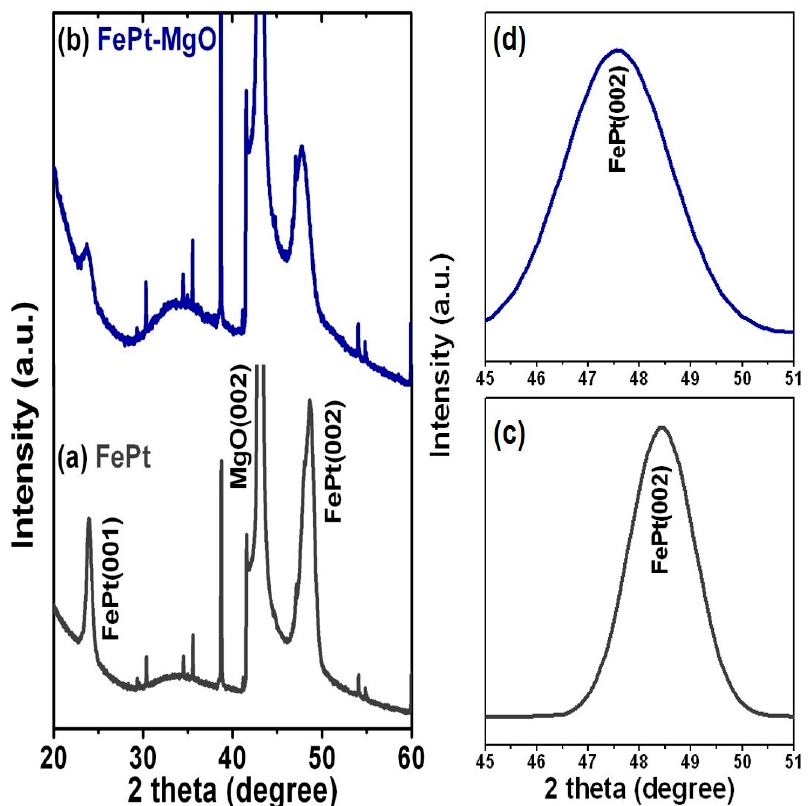
Figure 8. X-ray diffraction patterns ( θ –2 θ scans) for the FePt films ( a ) without and ( b ) with MgO additive nanolayers, respectively. The related slow scan peak curves of the FePt (002) in the θ –2 θ scan ( c ) without and ( d ) with MgO additive nanolayers, respectively.